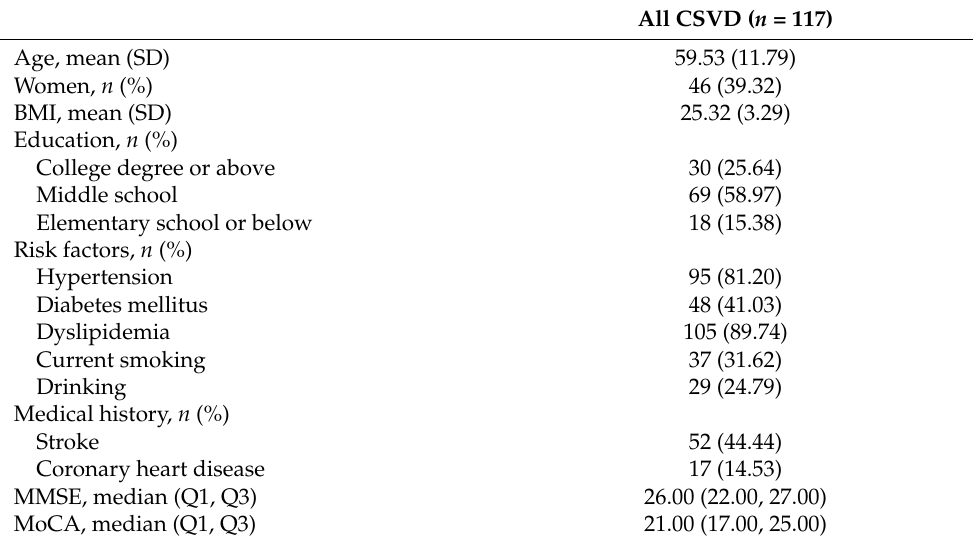
Table 1. Baseline characteristics of patients with